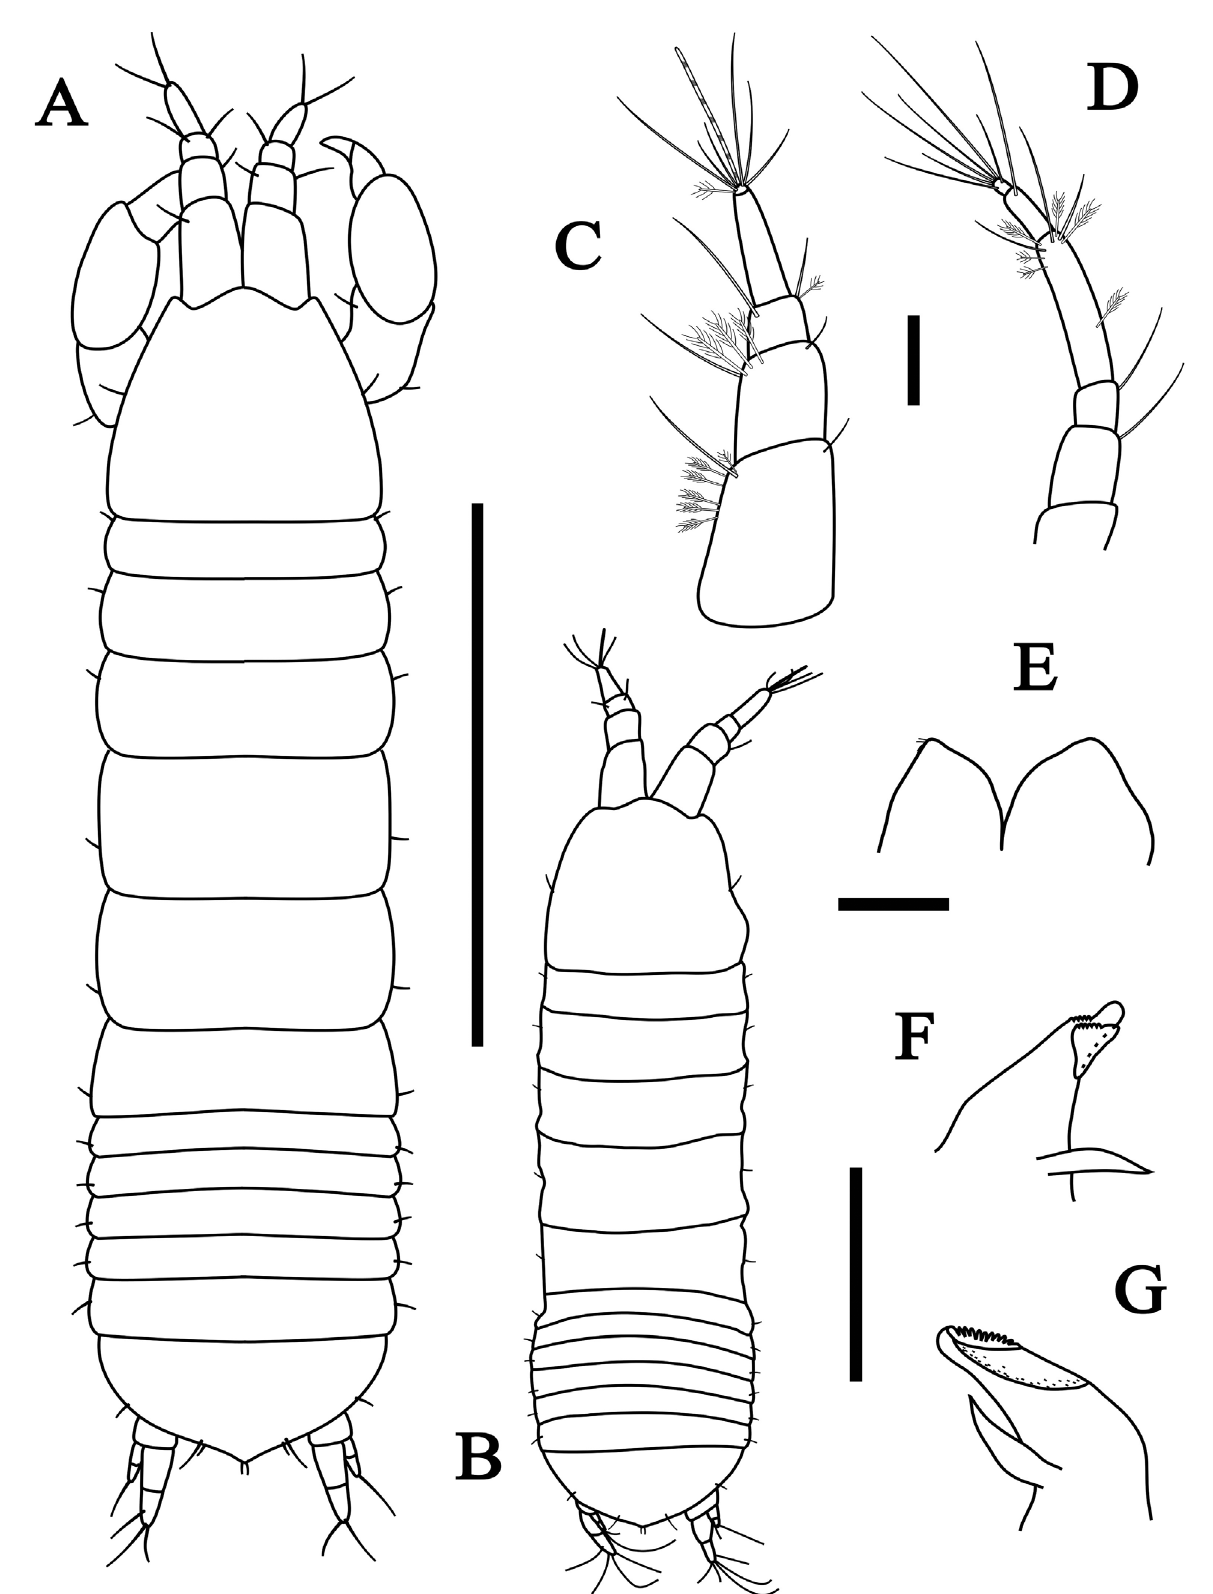
Figure 3. Tanaopsis brevicorpus sp. nov., female paratype, length 2.8 mm, MNRJ 23401. A, female dorsal view; B, manca dorsal view, length 1.3 mm; C, antennule, D, antenna, E, labium, F, left mandible, G, right mandible. Scale bars: A-B = 1 mm; C-G = 0.1